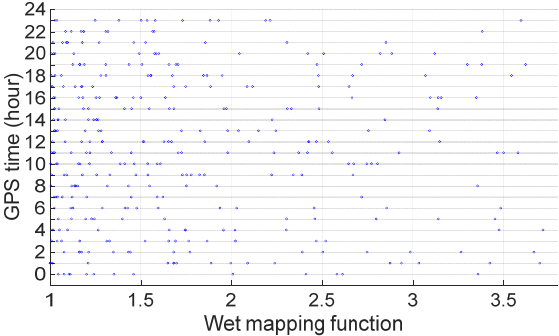
Figure 11. Wet mapping functions of observed satellites. Table 10. Fixing rate of the single ‐ epoch ambiguity resolution of a subset of narrow lanes L1 and L5 (%).